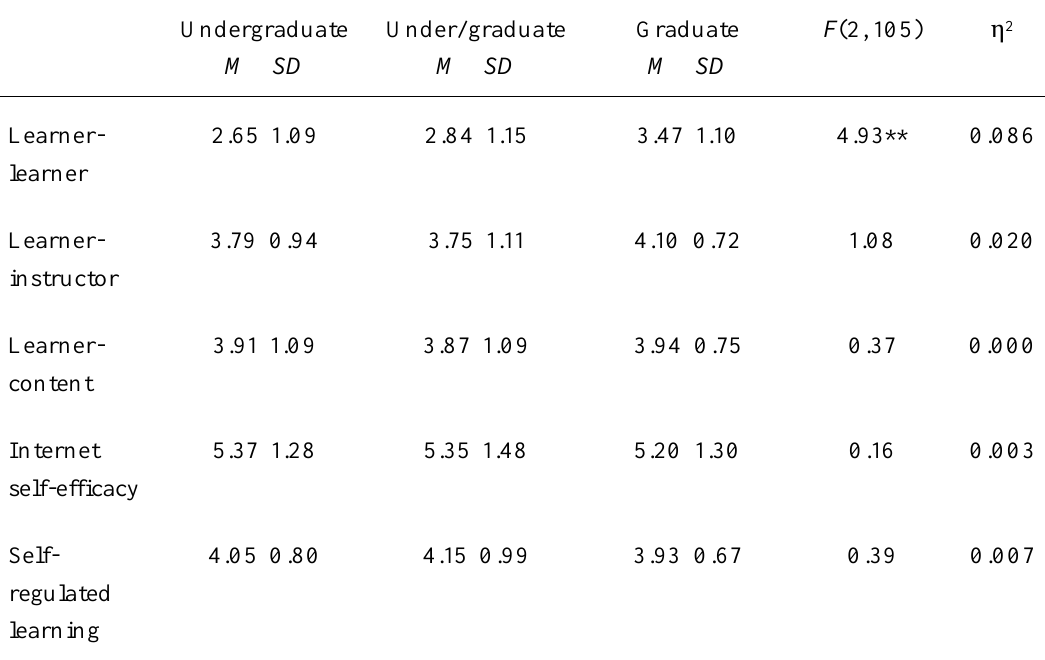
One-Way ANOVA of Class Level on Predictor